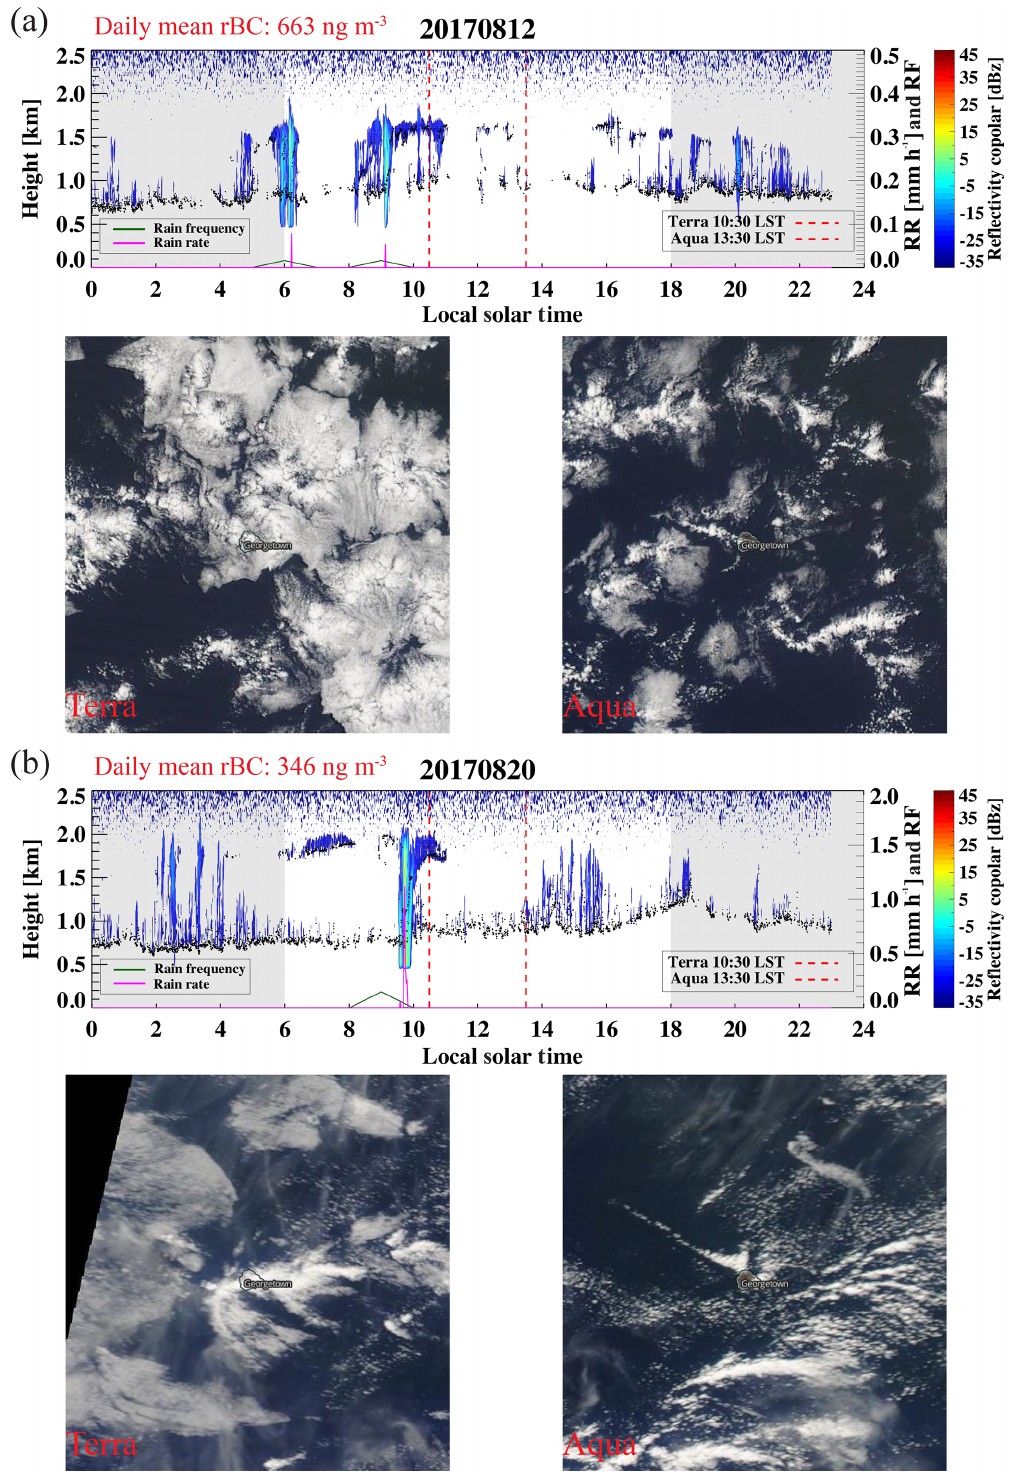
Figure 11. First and third rows: daily time series of the Ka-band zenith pointing cloud radar reflectivities (colored contour), disdrometer- derived 1min rain rates (RR, magenta), and 1h rain frequencies (RF, dark green), for (a) 12 August 2017 and (b) 20 August 2017. Ceilometer- detected cloud bases overlain in small black filled circles, Terra and Aqua overpass time indicated with red dashed lines. Second and fourth rows: corresponding 2 ◦ × 2 ◦ MODIS Terra and Aqua visible imagery centered on